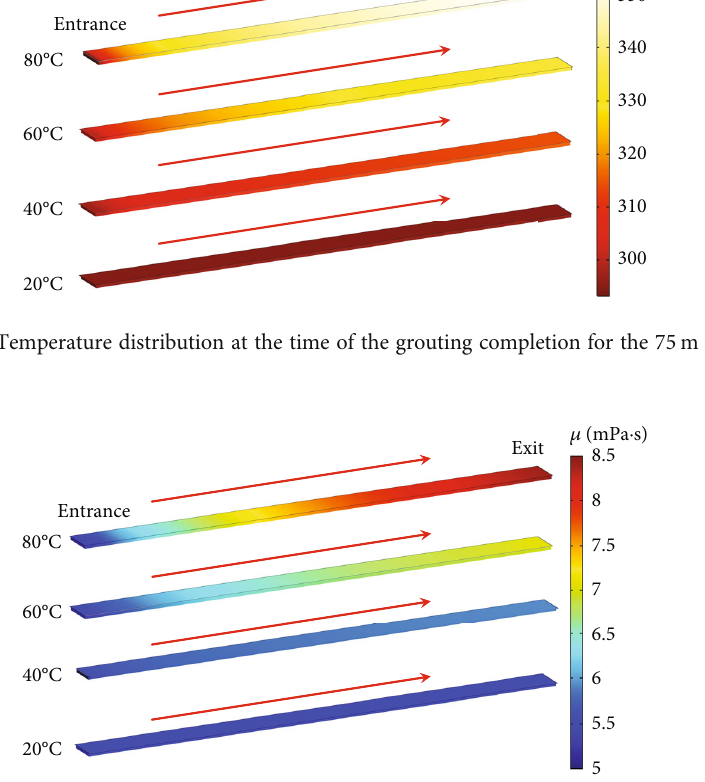
Figure 11: Dynamic viscosity distribution at the time of the grouting completion for the 75 m